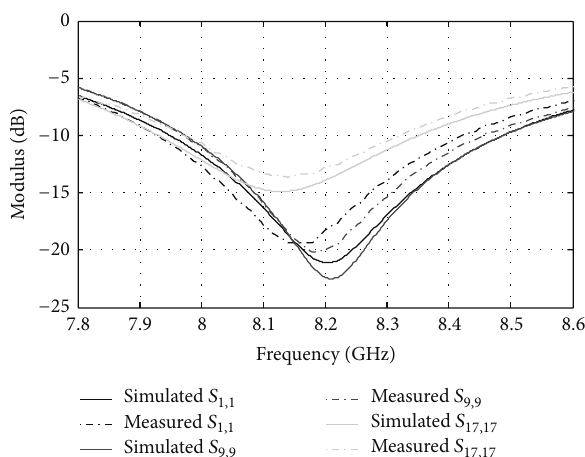
Figure 5: Simulated and measured matching coefficients corre- sponding to central and border pixels.